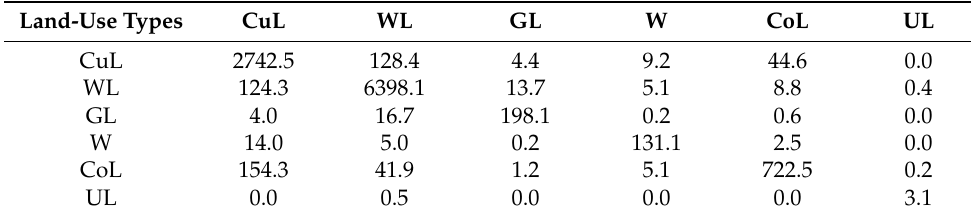
Table 5. Land-use transfer matrix for 2015 to 2018 ( km 2 ).